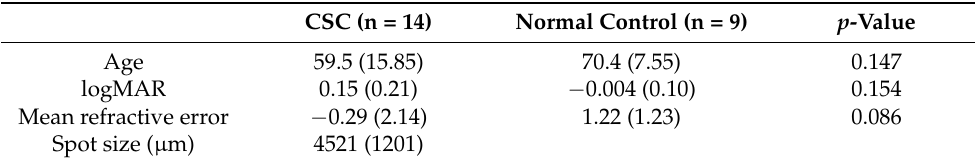
Table 1. The demographics of patients and